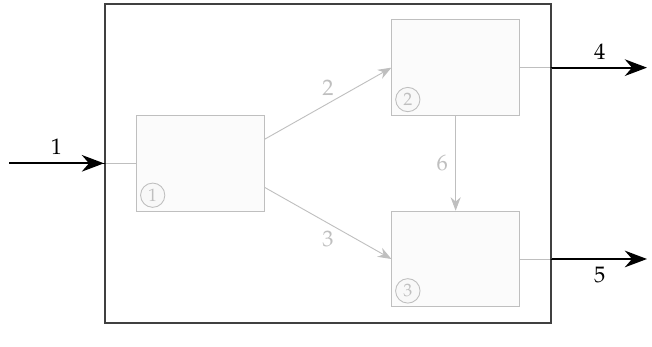
Figure 6. Aggregated system of Figure